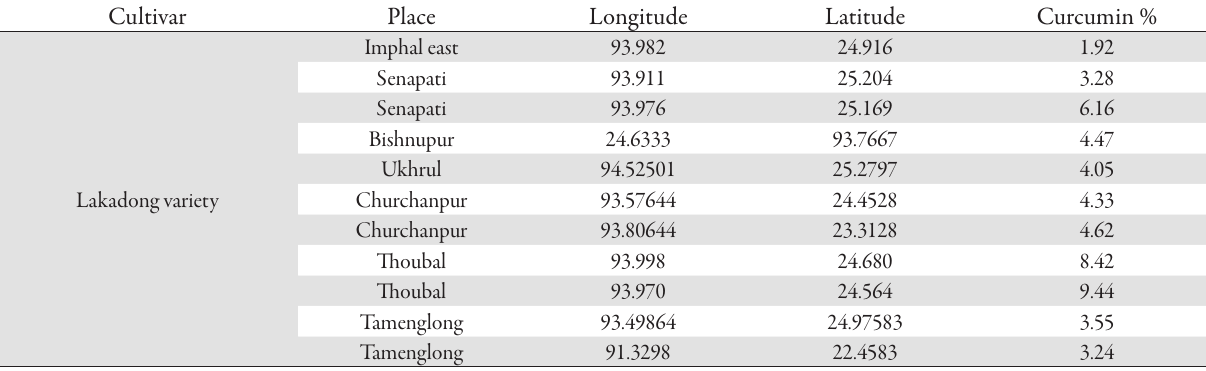
in in vitro multiple shoots formation (n = 20) 3 3